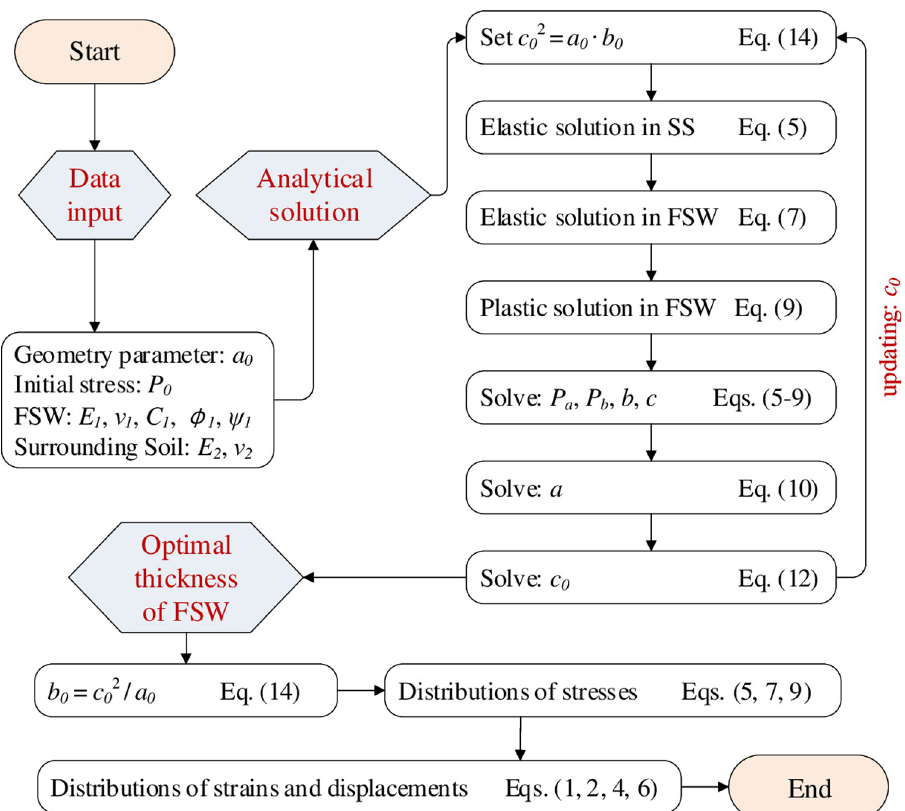
Fig 2. Flowchart of the analytical solution for calculation of the optimal thickness of the